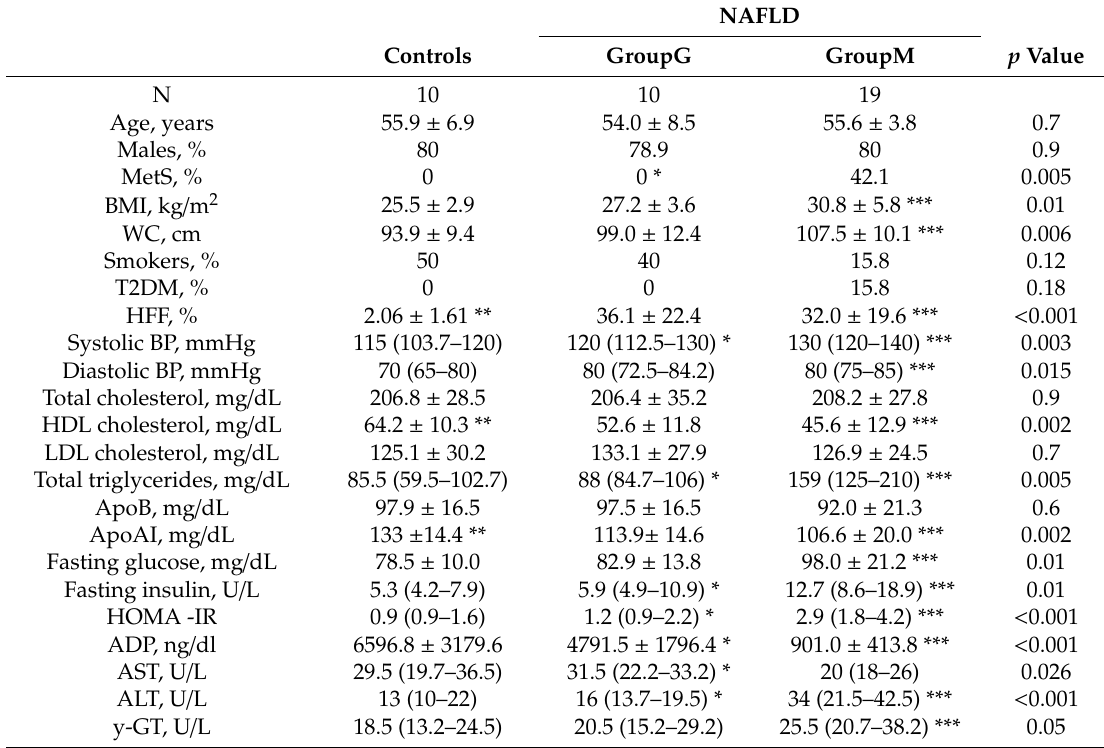
Table 1. Anthropometric and metabolic profiles of study groups.